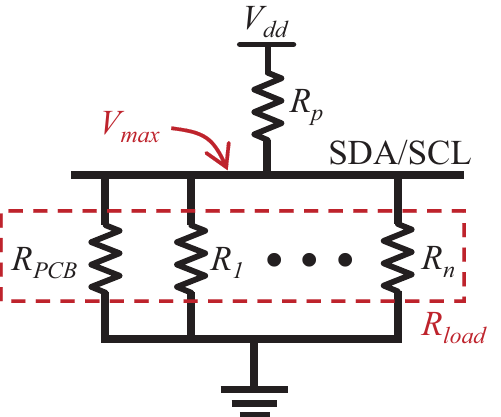
Figure 8. Equivalent circuit of the SDA/SCL line. R i refers to the equivalent resistance of the i th IC ( i = 1 to n ) when the open-drain states the high impedance. R PCB is related to the materials of making the